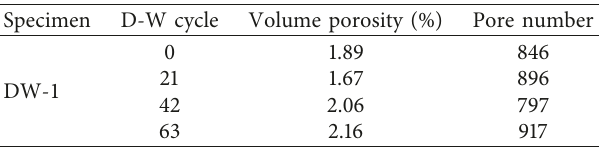
Figure 16: 3D reconstructed concrete and pores. (a) 3D concrete (aggregates in white and pores in black). (b) 3D pore without sulfate attack. (c) 3D pore at the 63-day sulfate attack. Table 2: Statistical results of pore characteristics of DW-1 exposed to drying-wetting cycles with sulfate attack.